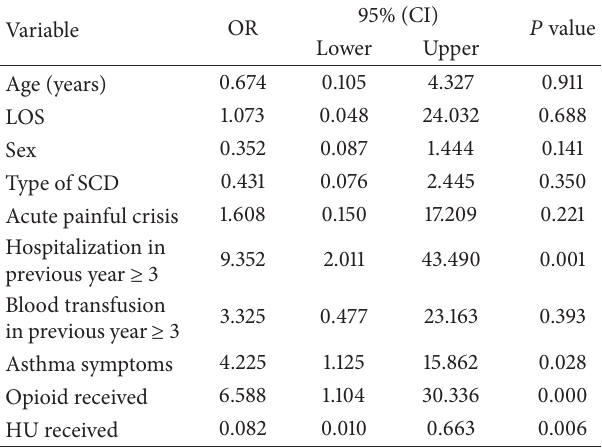
Table 6: Logistic regression analysis of different variables with